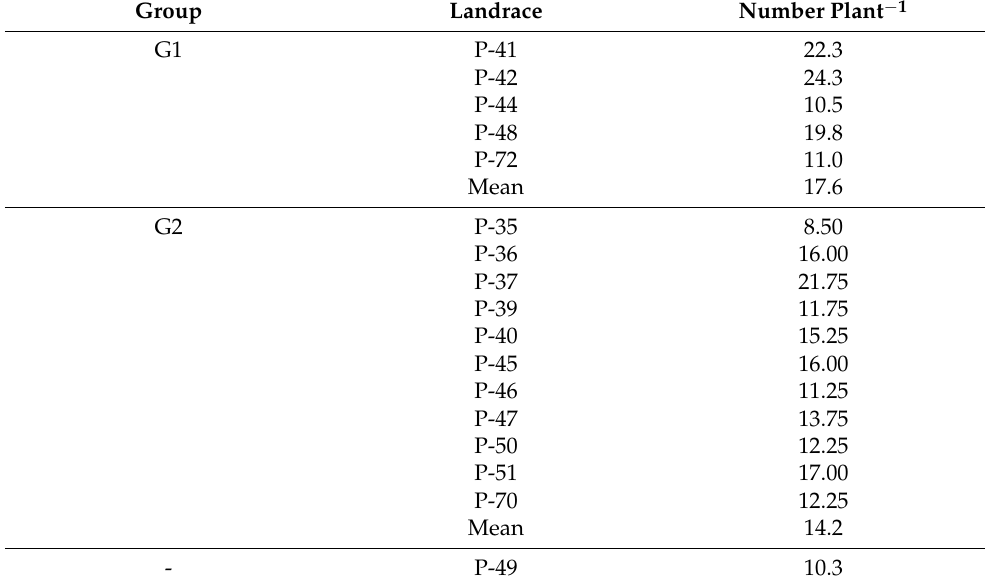
Figure 4. Morphological (( A ): length; ( B ): width; ( C ): pedicel length) traits of the fruit of the 17 pepper landraces in two ripening stages. Values are the mean ± SD of n = 10 fruit. Asterisks indicate significant differences of the red fruit to the green fruit for each landrace ( p < 0.05). Table 5. Productivity parameter number of fruits per plant ( n = 4) in the collection of the 17 pepper landraces cultivated in